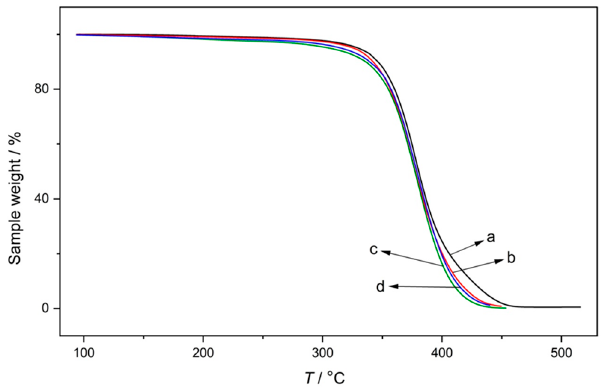
Figure 8. TGA curves of ( a ) crosslinked pure NR ( 2 NR) and semi IPN samples, ( b ) 2 NRM 35 , ( c ) 2 NRM 55 , and ( d ) 4 NRM 50 .